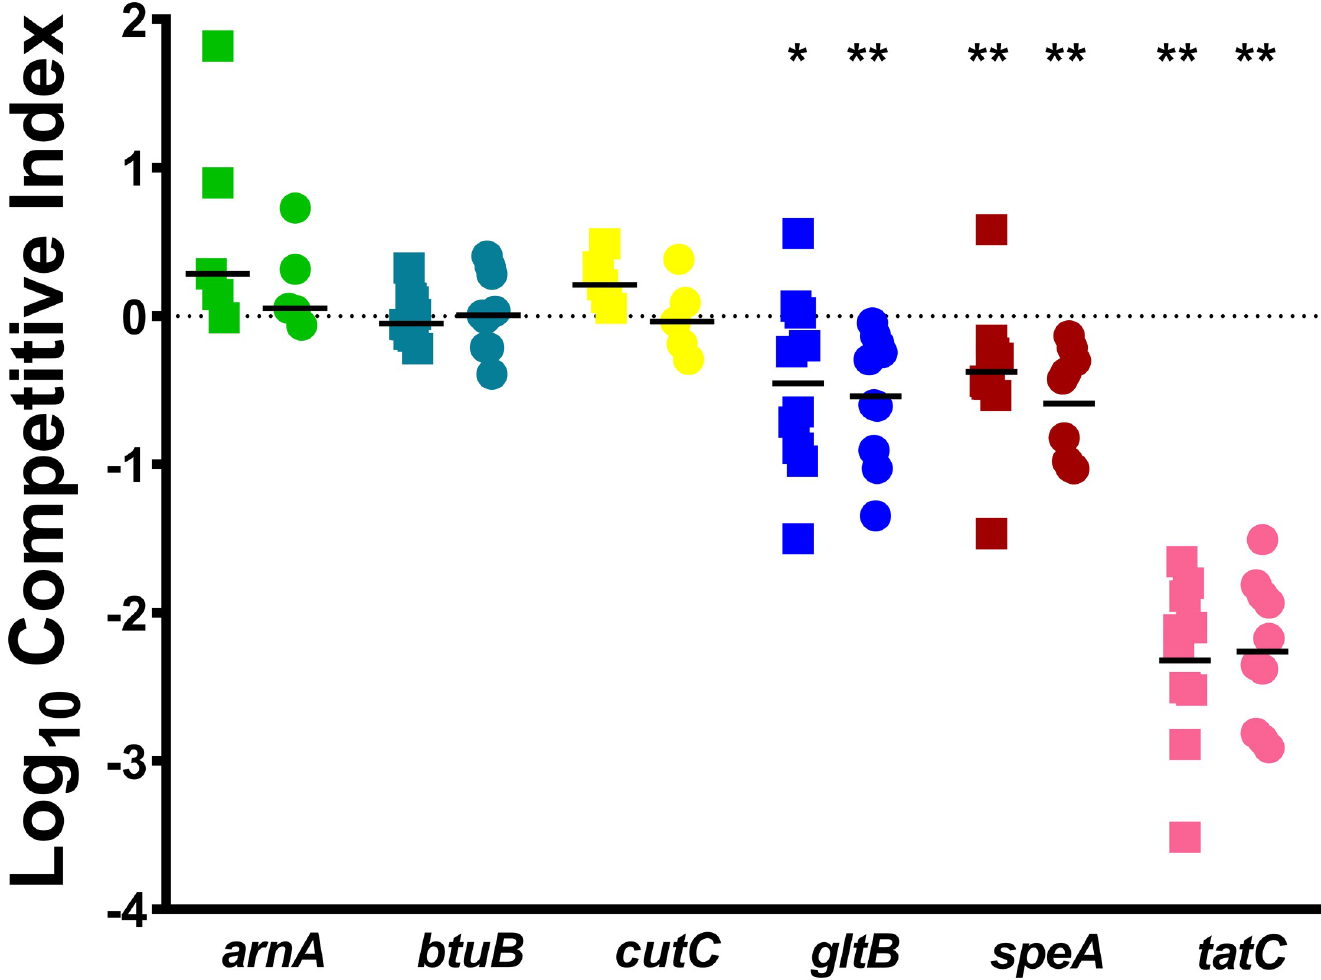
Fig 5. Disruption of gltB, speA , or tatC results in a fitness defect during direct co-challenge with WT P. mirabilis , while disruption of arnA, btuB , or cutC does not. CBA/J mice were inoculated via the tail vein with 1x10 7 CFU of a 1:1 mixture of wild-type P. mirabilis and an isogenic mutant. Liver and spleen were harvested from mice 24 hours post-inoculation, homogenized, and plated on LB agar and LB agar with kanamycin. A competitive index (CI) was calculated for each mutant on a per-mouse basis for the liver (square) and spleen (circle) from the ratio of mutant to wild-type recovered from the organ divided by the ratio of mutant to wild-type in the inoculum (see Materials and Methods). Each data point represents the Log10 CI from an individual mouse. Solid lines represent the median. Dashed lines indicate a competitive index of 1, or a 1:1 ratio of mutant to wild-type. � P < 0.05 and �� P < 0.01 as determined by Wilcoxon signed rank test.